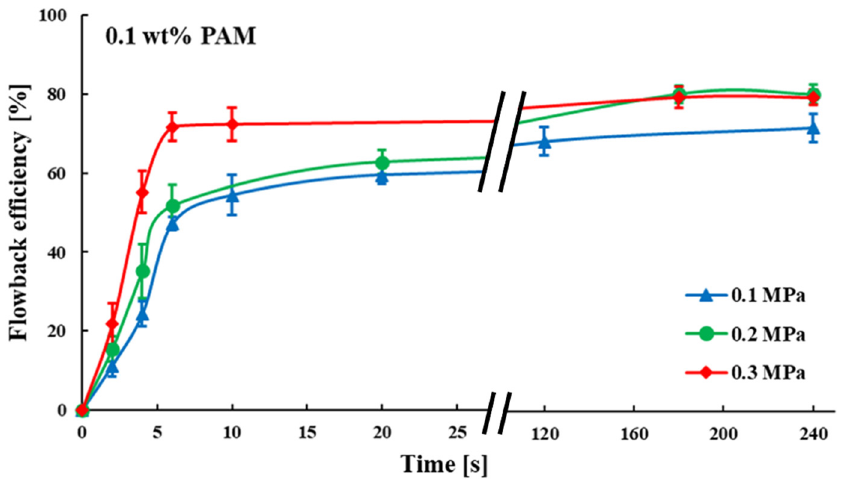
Figure 6. The fracturing fluid (0.1 wt%) flowback process images and binary images ( a ) 0.1 MPa gas drive, ( b ) 0.2 MPa gas drive, ( c ) 0.3 MPa gas drive.